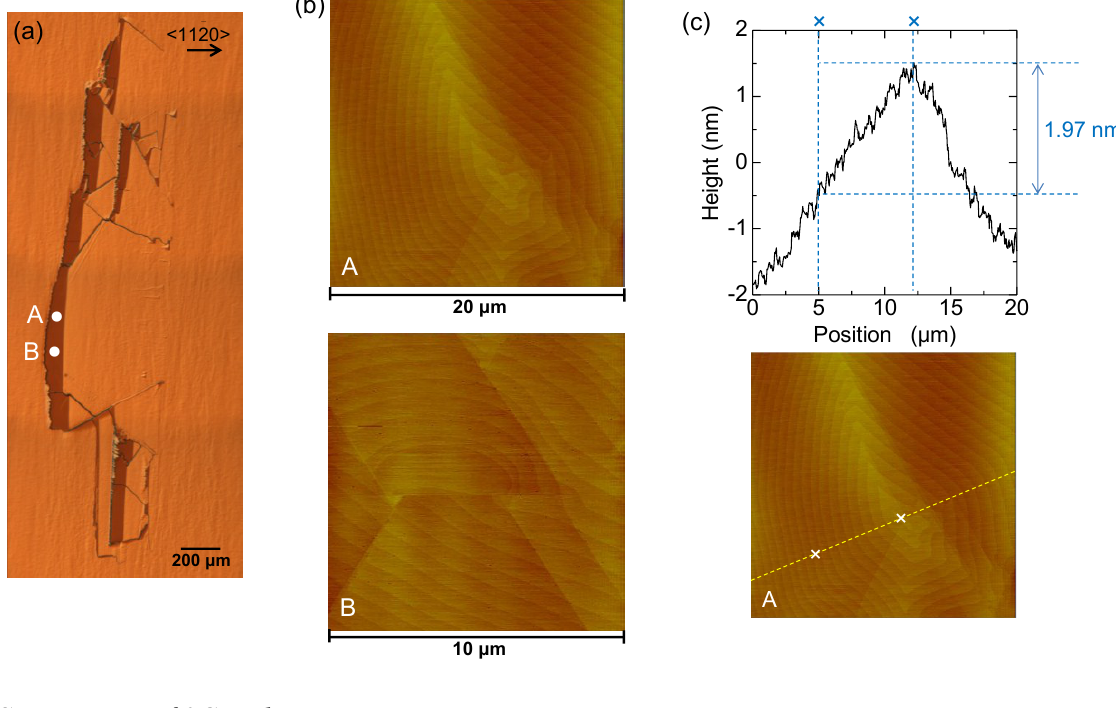
Figure 3. ( a ) NOM image showing atomic force microscopy (AFM) measuring positions (labeled A and B); ( b ) corresponding AFM images; ( c ) cross-sectional profile of the AFM image (yellow dashed line at position